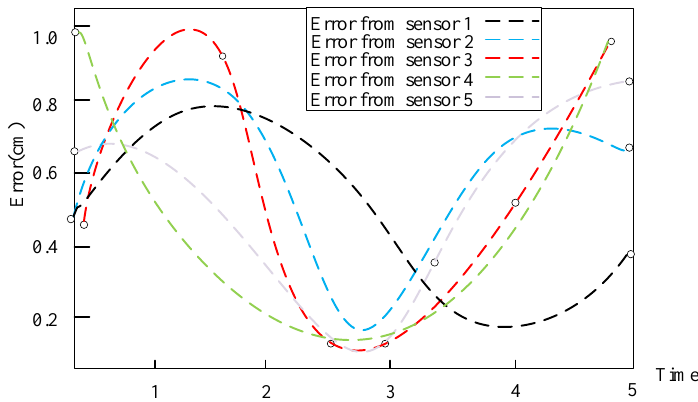
Figure 7. Reference inputs of channels with sensor 1 (S1), S2, S3, S4, and S5.